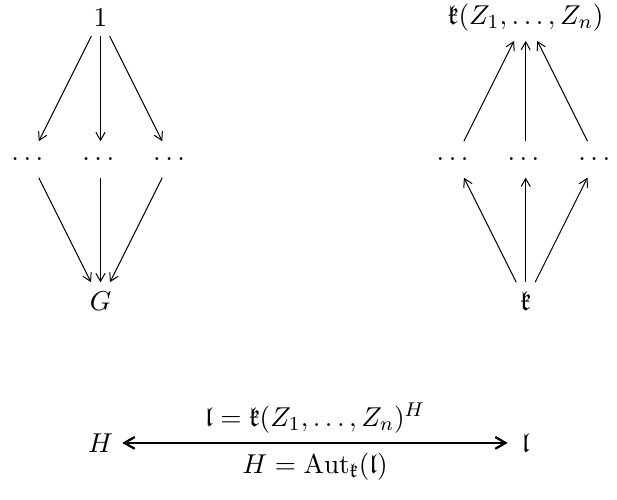
Figure 1 . Schematic Galois